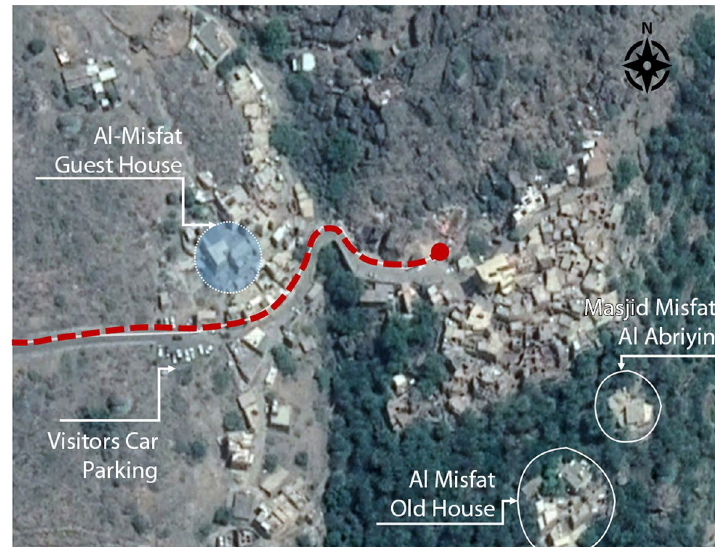
Fig. 4 Misfat al-Abriyin, 2021 (Source: Google satellite image, enhanced by the